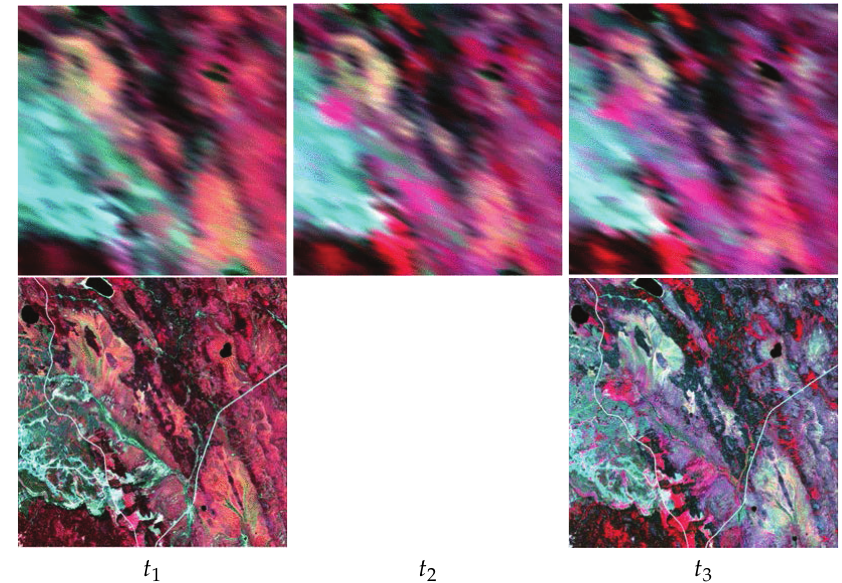
Figure 3. Predicting the Landsat image at date t 2 from Landsat images at dates t 1 and t 3 and MODIS images at all